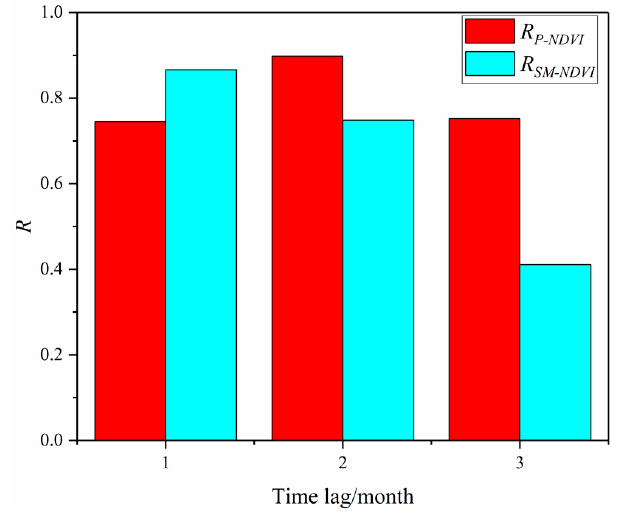
Figure 11. Time lag e ff ects between NDVI and precipitation and soil